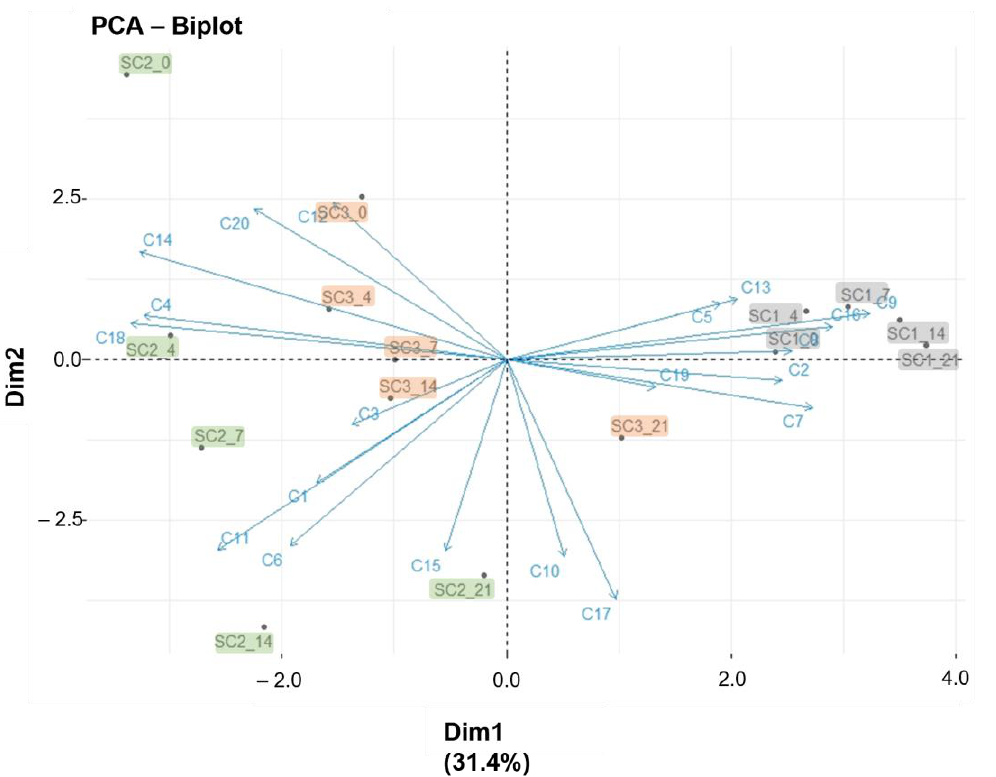
Figure 7. PCA plot corresponding to VOCs detected by SPME-GC-MS in ST kombucha fermented using SCOBYs 1, 2, and 3 (SC1, SC2, SC3) over 21 days. Arrows refer to the VOCs (C1 to C20) listed in Table 1. Samples of kombucha beverages are colored in gray (SC1), green (SC2), or orange (SC3). Numbers 0, 4, 7, 14, 21 refer to the storage period in days.